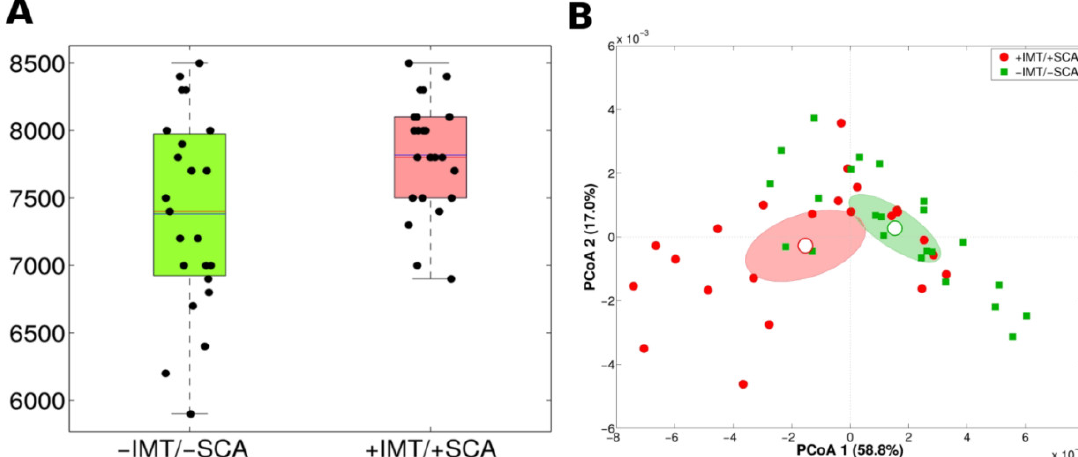
Figure 2. Hit functional markers associated with +IMT/+SCA. ( A ) Boxplots deriving from level L4 of the MetaCyc pathway hierarchy based on shotgun metagenome sequencing of +IMT/+SCA ( n = 23) and − IMT/ − SCA ( n = 23) individuals as determined by “observed_species” metric. ( B ) Principal Coordinates Analysis (PCoA) plots of Bray-Curtis distances among +IMT/+SCA and − IMT/ − SCA samples calculated on level L4 functional MetaCyc pathway classification. Each point represents a sample; centroids are calculated as the mean coordinate of all samples per experimental category; ellipses represent the standard error of the mean (SEM)-based estimation of the variance. The first and second components of the variance are